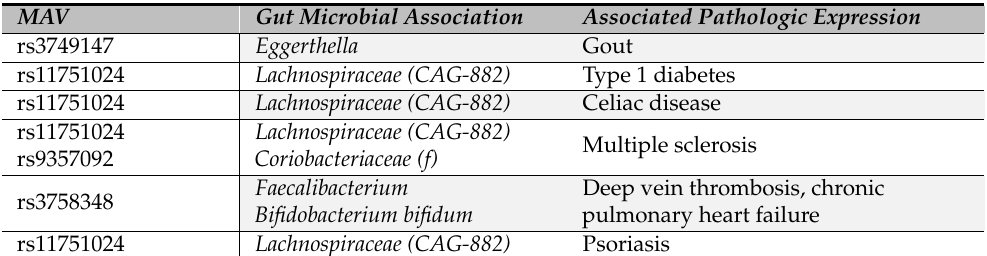
Table 1. MAV, gut microbial association and disease